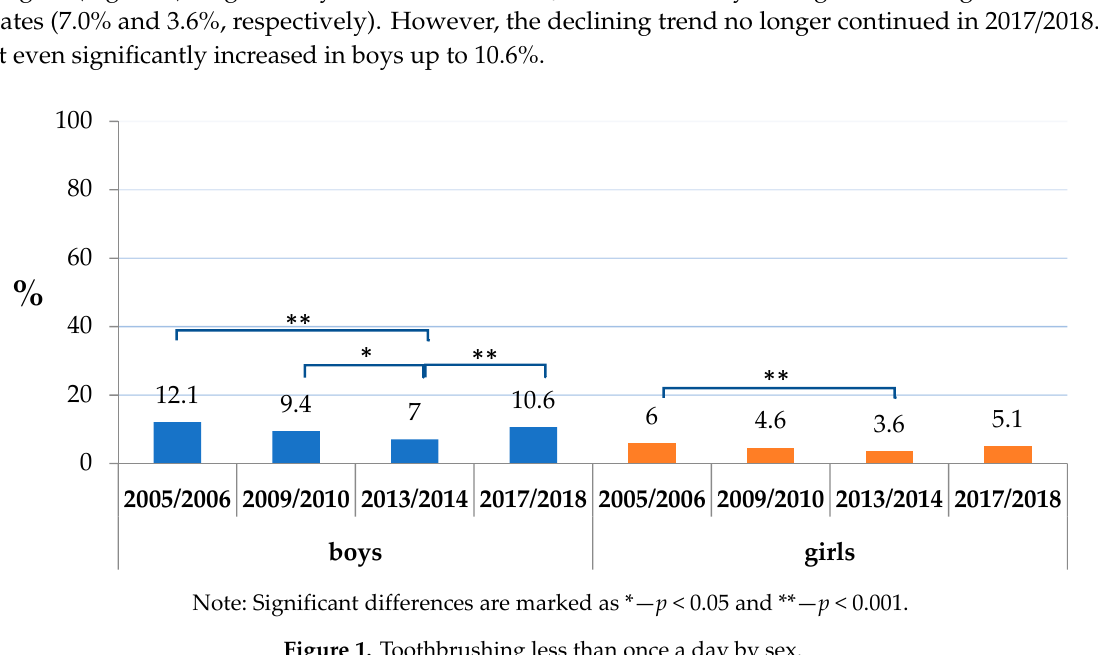
Table 4. Prevalence of the selected risk factors of caries by socioeconomic status in 11-13-year-old girls.